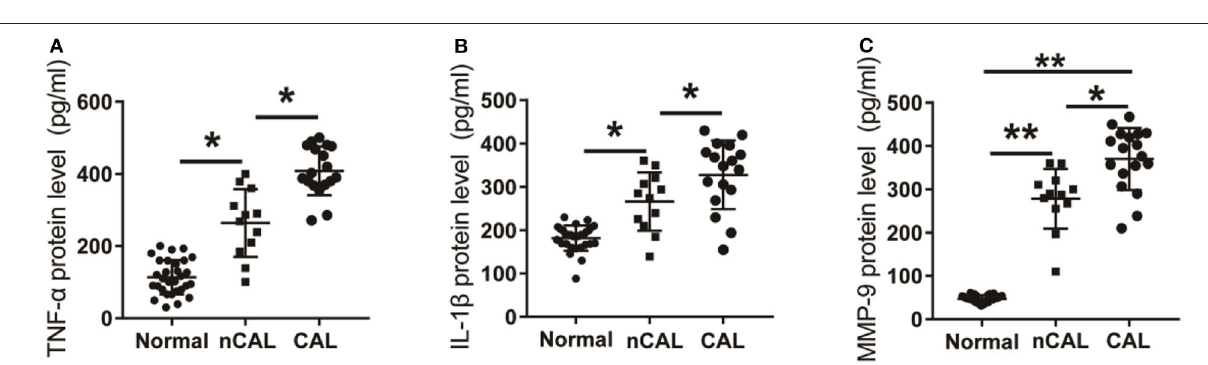
FIGURE 7 | Expression of inflammatory factors in peripheral blood of KD patients and control children with CAL or nCAL. (A) TNF- α protein level in peripheral blood of patients with or without CAL; (B) IL-1 β protein level in peripheral blood of patients with CAL or nCAL; (C) MMP-9 protein level in peripheral blood of patients with CAL or nCAL. * P < 0.05; ** P <